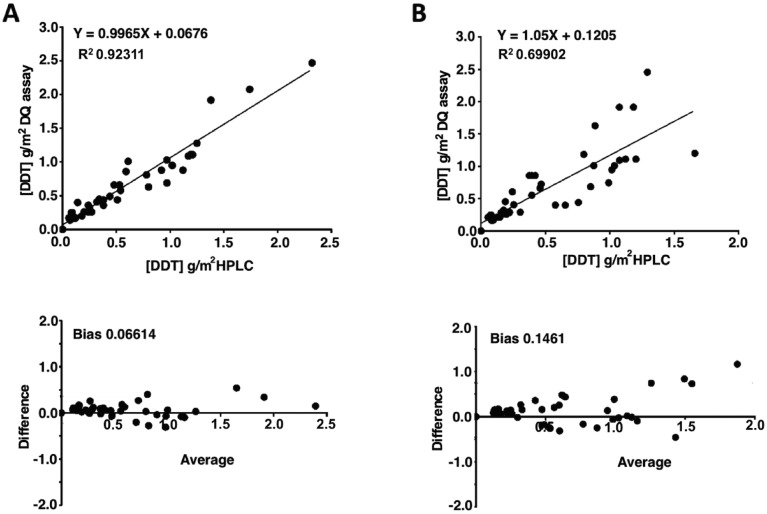
Comparison of DDT extraction from rough tile surfaces by Bostik adhesive discs and sellotape.A. Bostik disc correlation, R2 = 0.92311 (top), and Bland Altman bias, 0.06614 (below). B. Sellotape correlation, R2 = 0.69902 (top), and Bland Altman bias, 0.1461 (below).